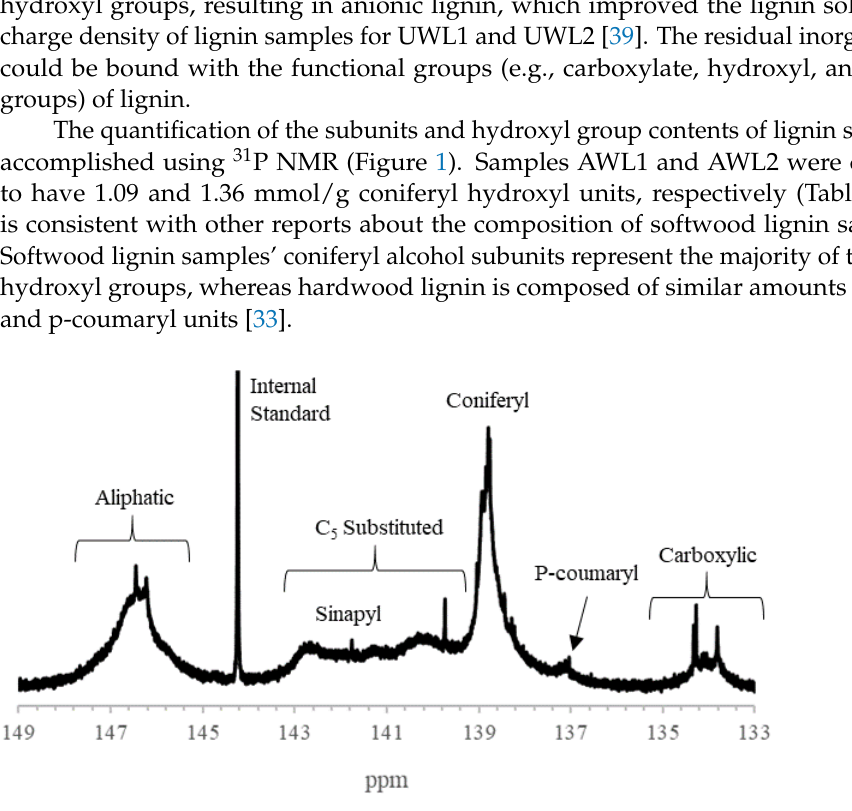
Figure 1. 31 PNMR spectrum of AWL1 with aliphatic ( δ 145.4–150.0 ppm), C 5 substituted ( δ 140.0–144.5 ppm), Sinapyl ( δ ≈ 142.7 ppm), conideryl ( δ 139.0–140.2 ppm), p-coumaryl ( δ ≈ 137.8 ppm), and carbocyclic ( δ 133.6–136.0ppm). Table 2. Aliphatic, carboxylic, and phenolic hydroxyl group contents of unmodified acid-washed lignin samples. (± 0.03 mmol/g).